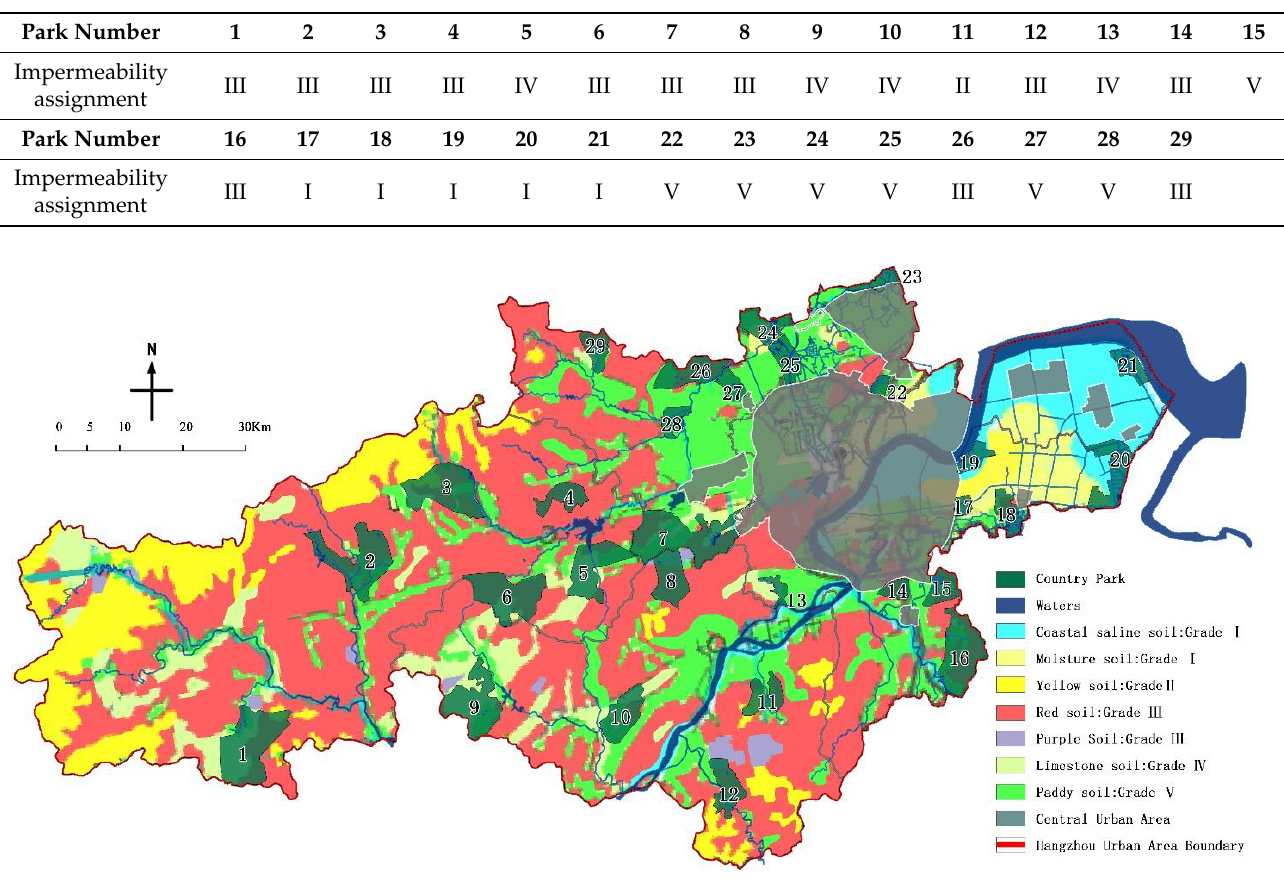
Figure 10. The impermeability distribution of the country parks.